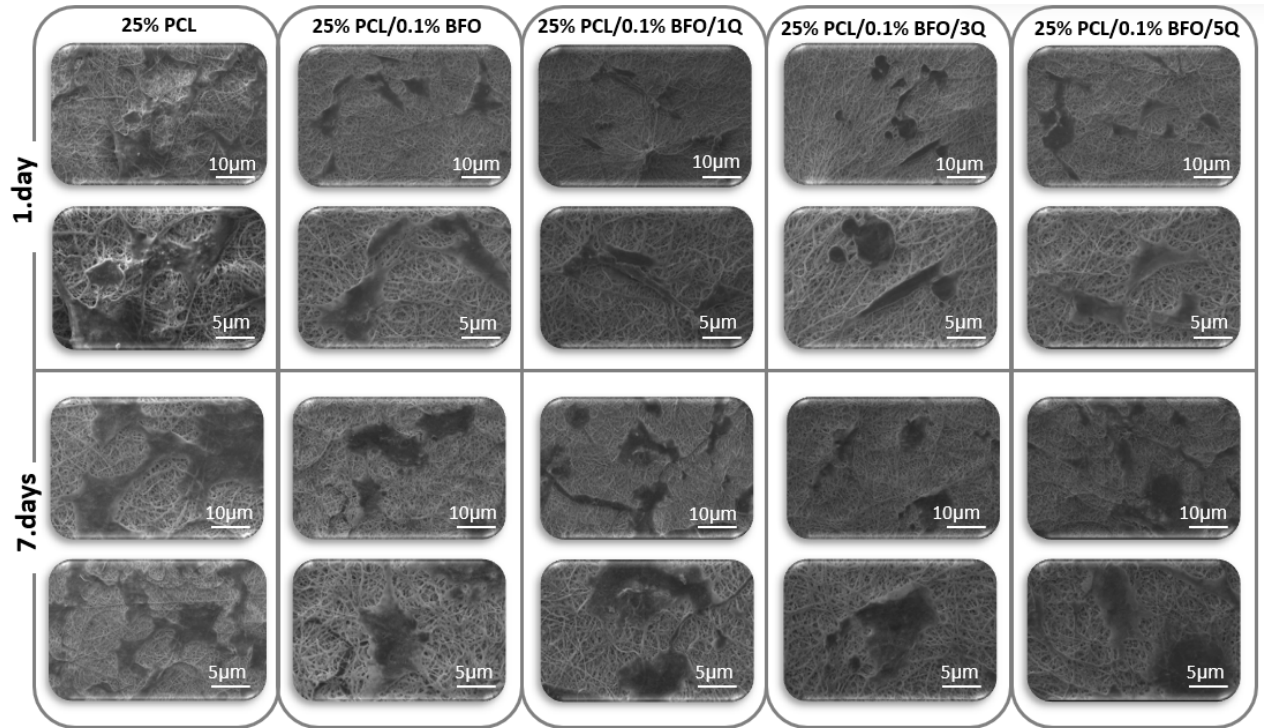
Figure 10. SEM images of the cultured MSCs’ adhesion to each microfibrous scaffold after 1 and 7 days of incubation.